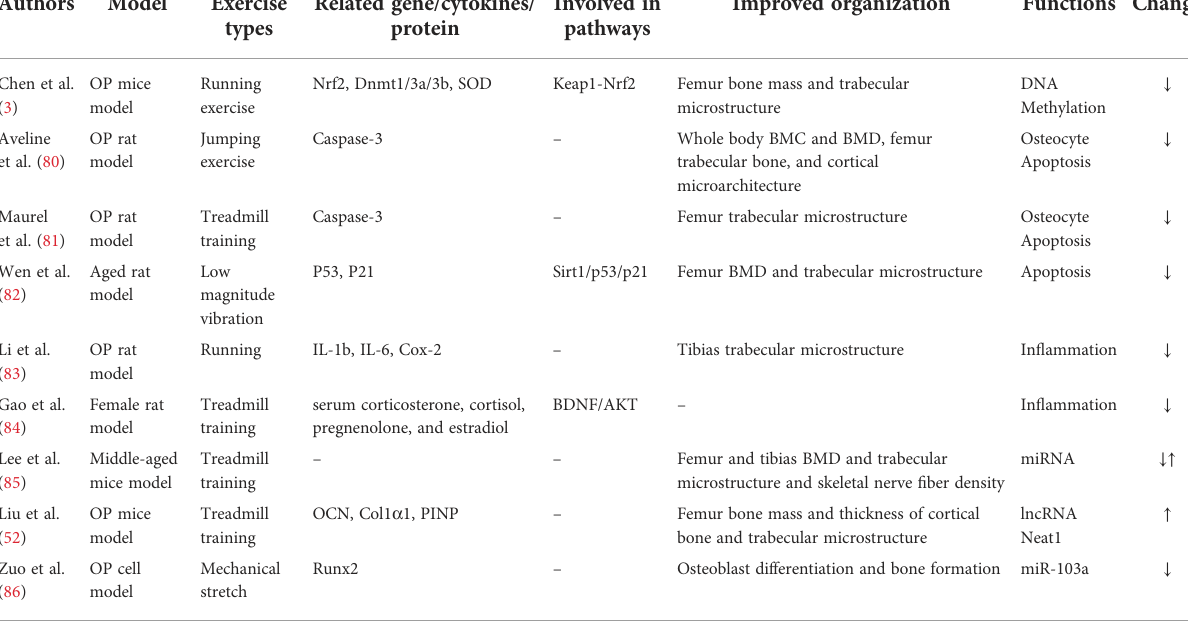
TABLE 1 Mechanism of exercise in the treatment of osteoporosis (OP) in